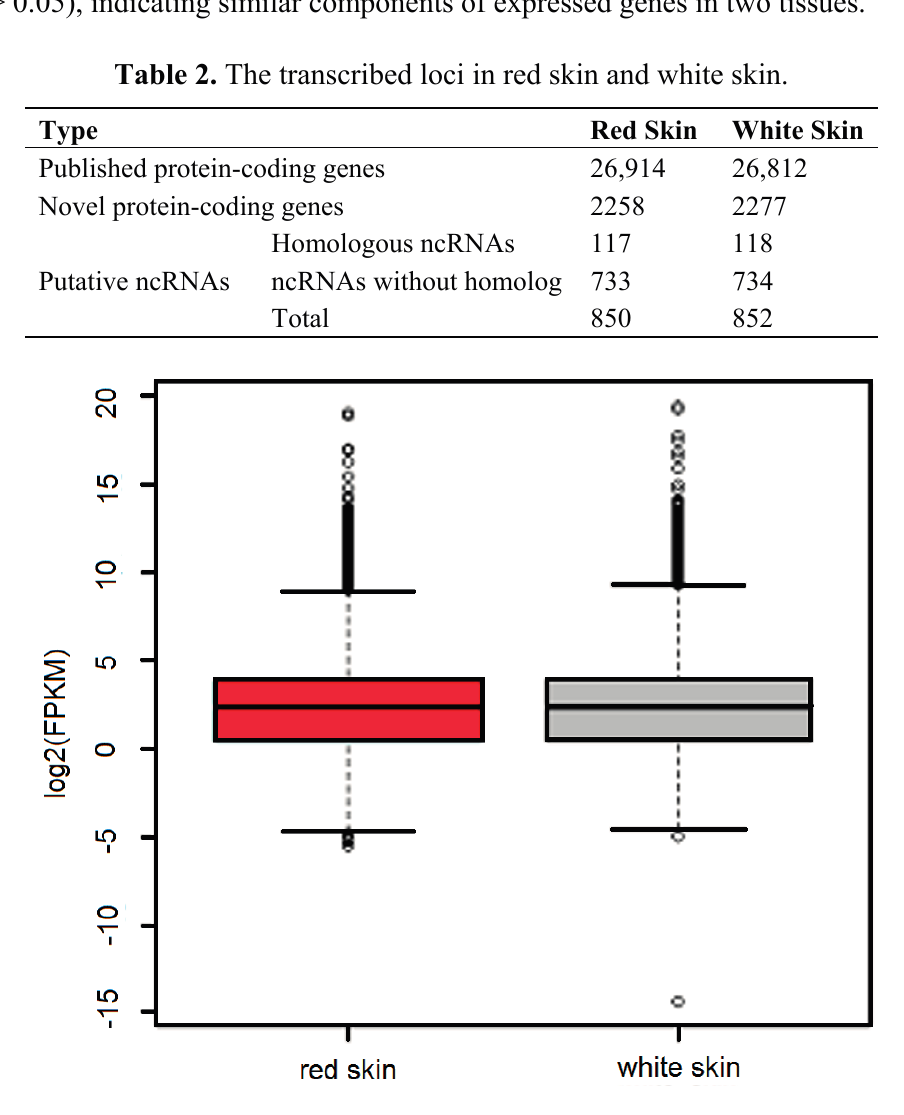
Figure 1. Overview of the expression levels in red skin and white skin. Whisker plots of expression (with whiskers representing the range of the distribution) showed the global gene expression levels in red skin ( red ) and white skin ( grey